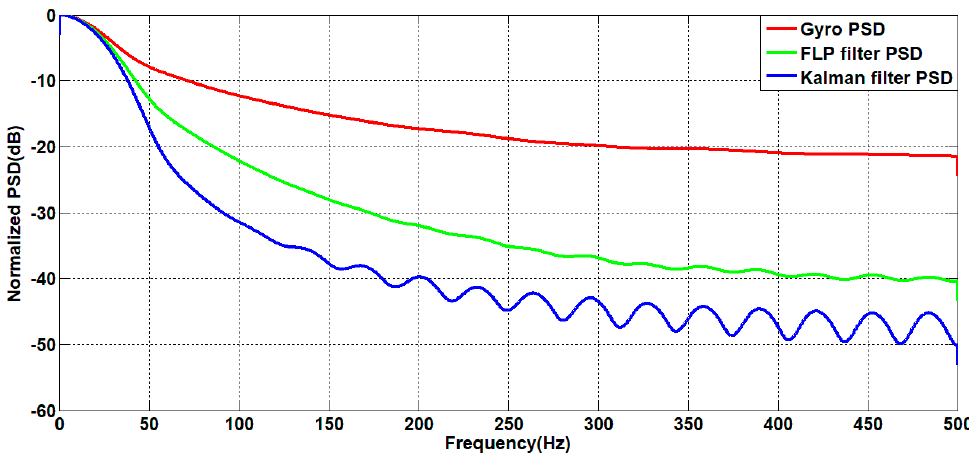
Figure 20. Power spectrum curve before and after filtering.